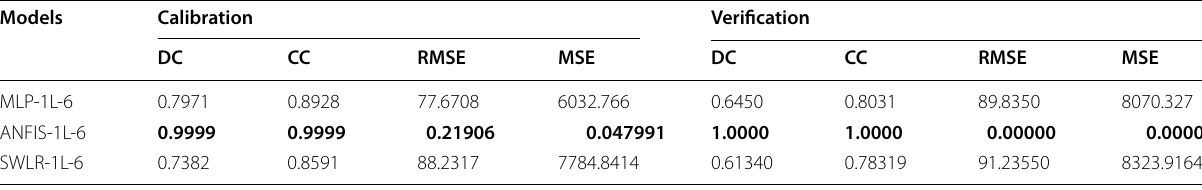
Table 3 Performance of 1L-6 inflammatory biomarker